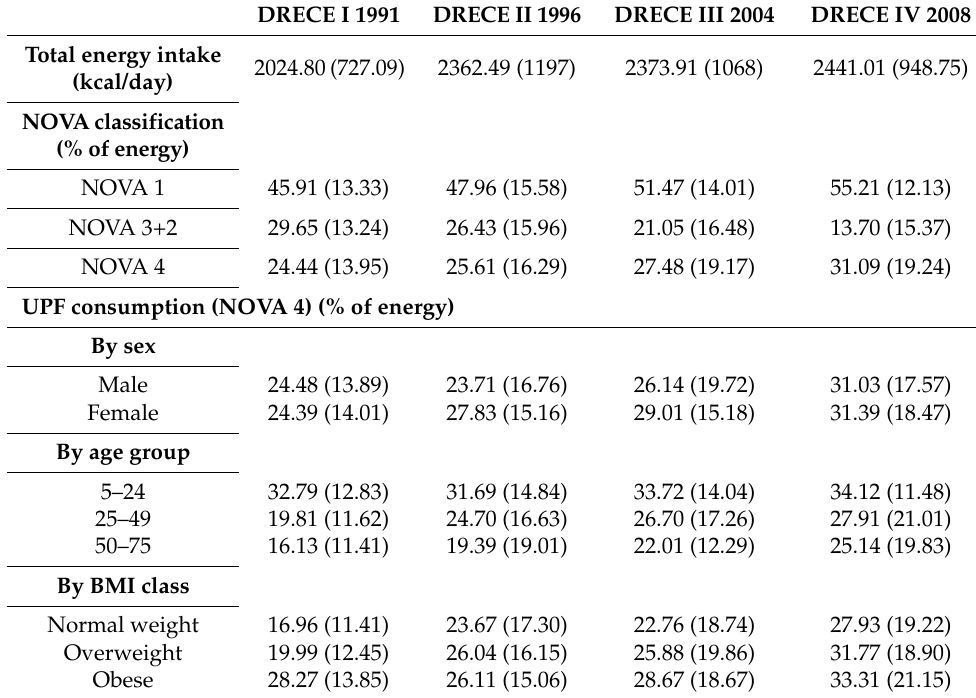
Table 1. Food intake according to the NOVA classification over time (DRECE cohorts) and distribution of ultra-processed food consumption (NOVA 4) by sex, age, and BMI